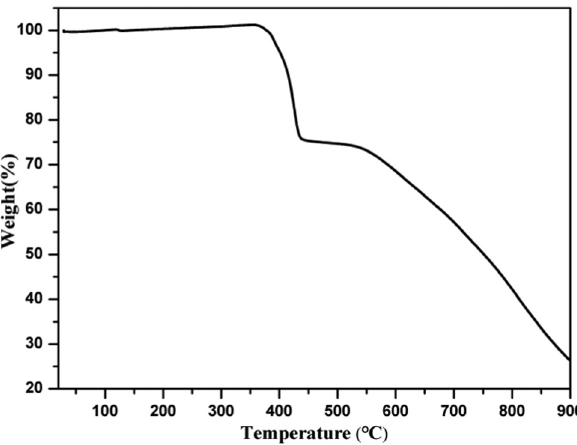
Figure 7: Thermal analysis curve of 1 .